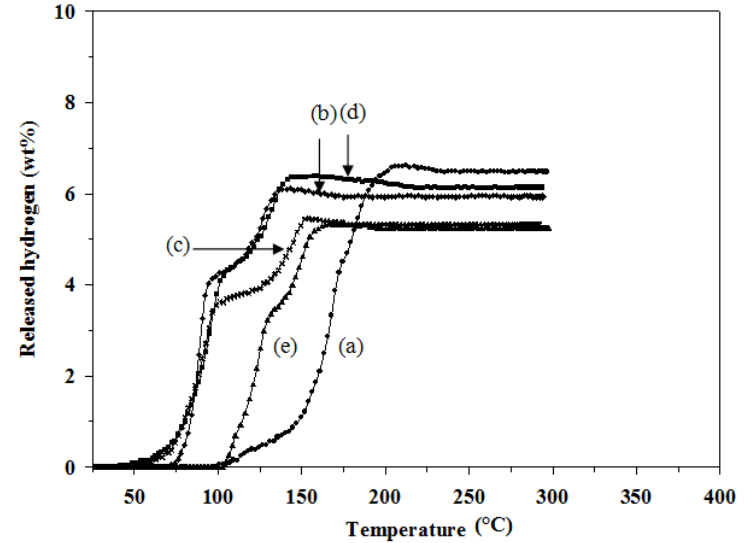
+LiBH ; ( b ) 1 mol % ZrCl 4 4 –2LiAlH +LiBH ; ( d ) 1 mol % TiCl –2LiAlH 3 4 4 3 +LiBH . 4 4